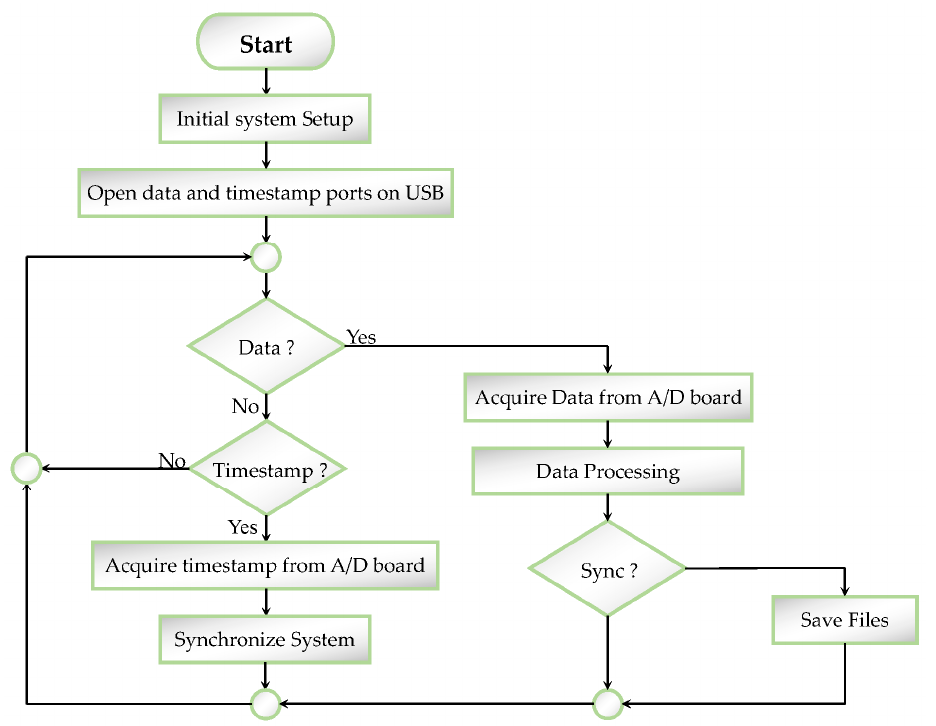
Figure 6. Flux diagram of the programs uploaded on the Raspberry-Pi.